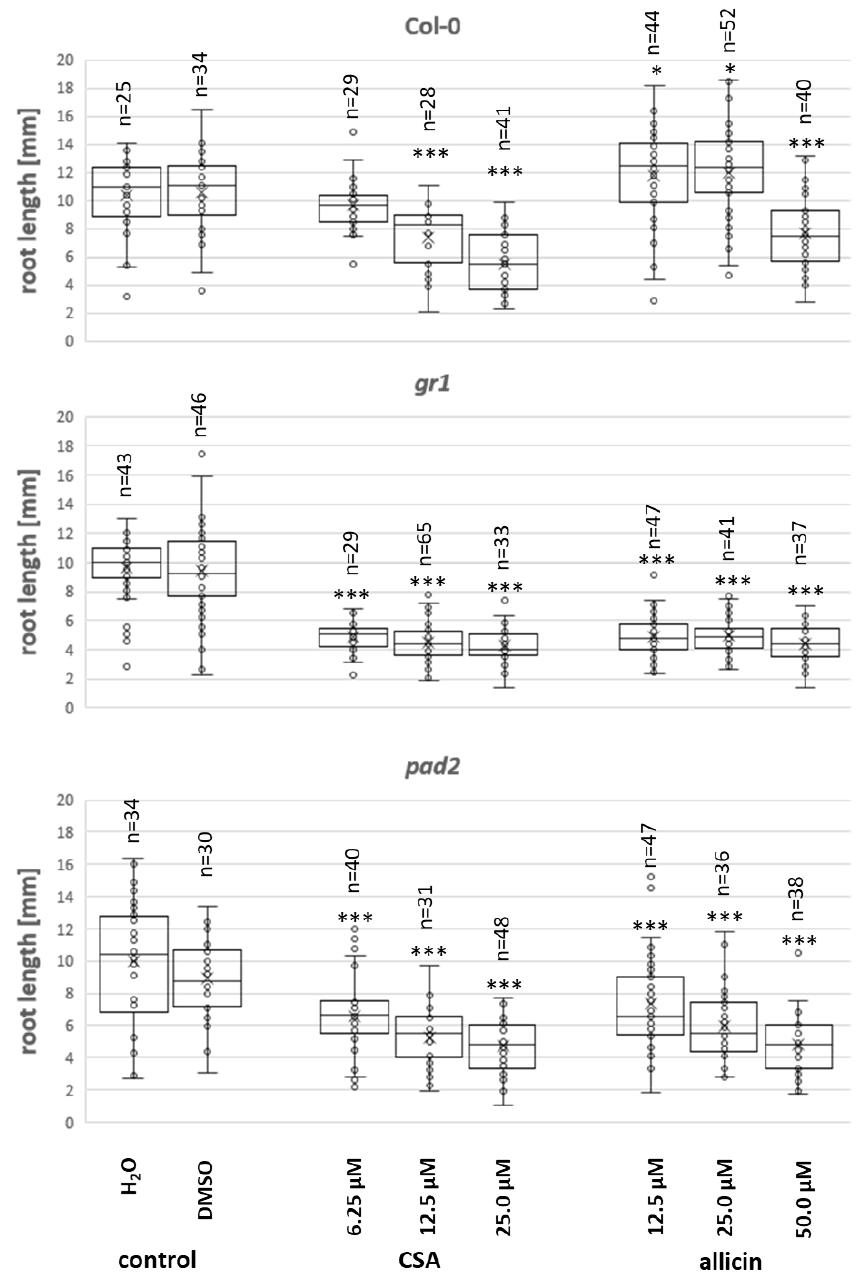
Figure 4. E ff ects of CSA and allicin on seedling root growth of Arabidopsis thaliana Col-0 (wildtype), a mutant with reduced glutathione ( pad2 ), and a mutant lacking glutathione reductase ( gr1 ). The box plots show the range of the data, the mean (x), the median (horizontal line), and standard deviation (box). A t -testofeachsample-groupagainsttheuntreatedcontrolwasperformed. Fornon-normallydistributed data, the test was carried out on ranks (Wilcoxon–Mann–Whitney test): *: p < 0.05; ***: p <